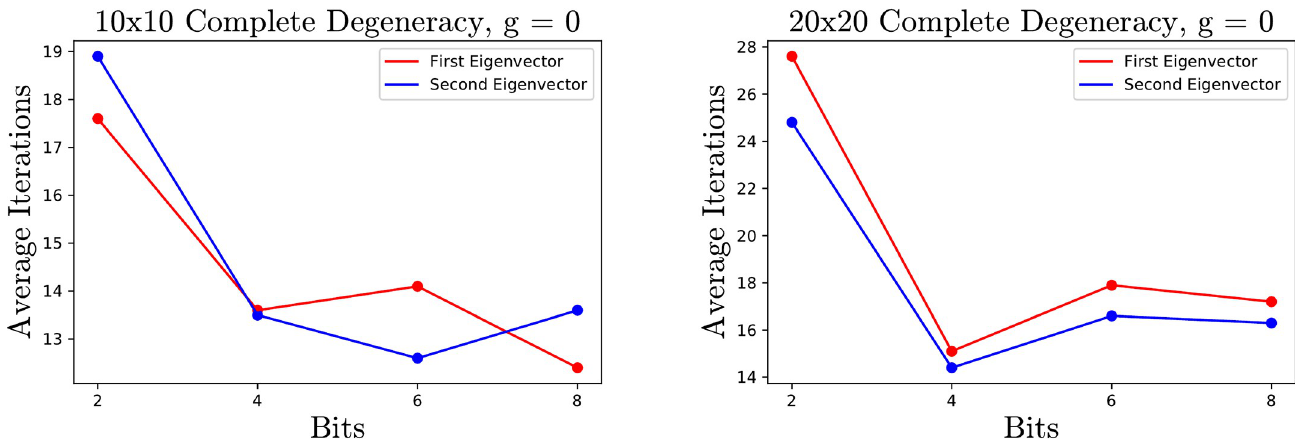
Fig 9. Average number of iterations running the algorithm twice on matrices with complete degeneracy. One can see slightly better performance on the second run, particularly on the 20 × 20 matrices.